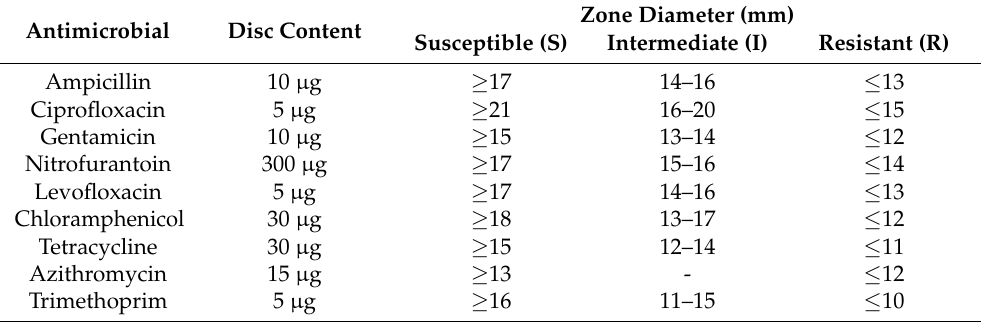
Table 2. Antimicrobial sensitivity reference table